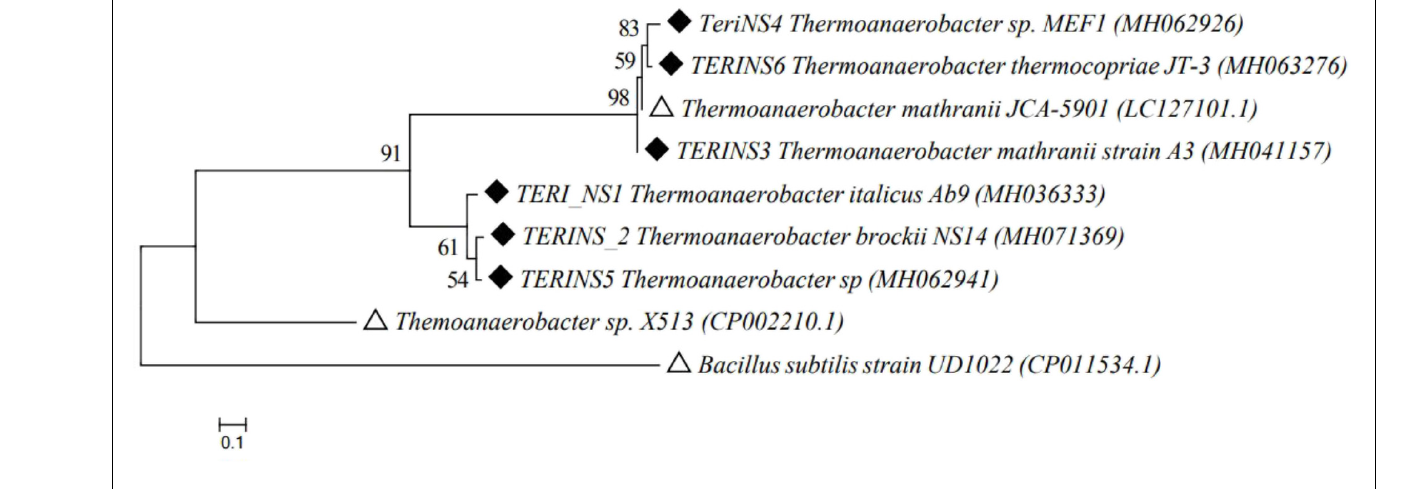
FIGURE 4 | Phylogenetic tree of 16S rRNA gene sequences retrieved from Thermoanaerobacter culture TERIJ-188 and closely related species from GenBank database. The topology of tree was obtained by a Neighbor joining method, with bootstrap values ( n = 1000 replicates) of nodes reported, using MEGA 6.06 software. Scale bar = nucleotide substitutions per site. Outgroup and reference species were represented with (cid:49) whereas the isolated strains were represented with (cid:7)